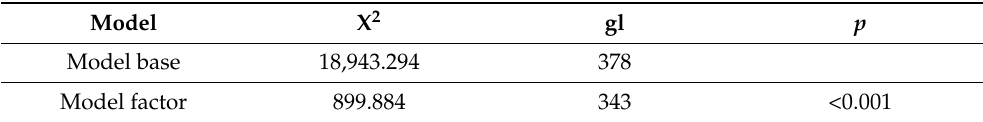
Table 9. Adjusted confirmatory factor analysis.